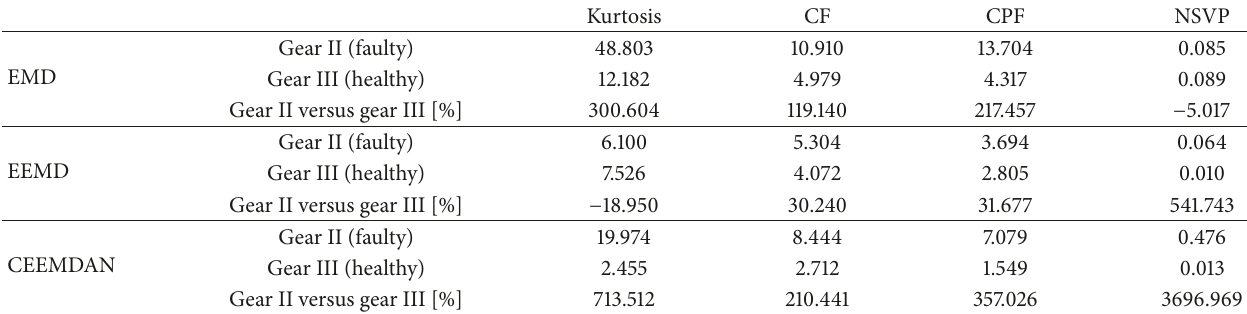
Table 5: CIs for the vibration signal of Case 2, with localized fault in gear